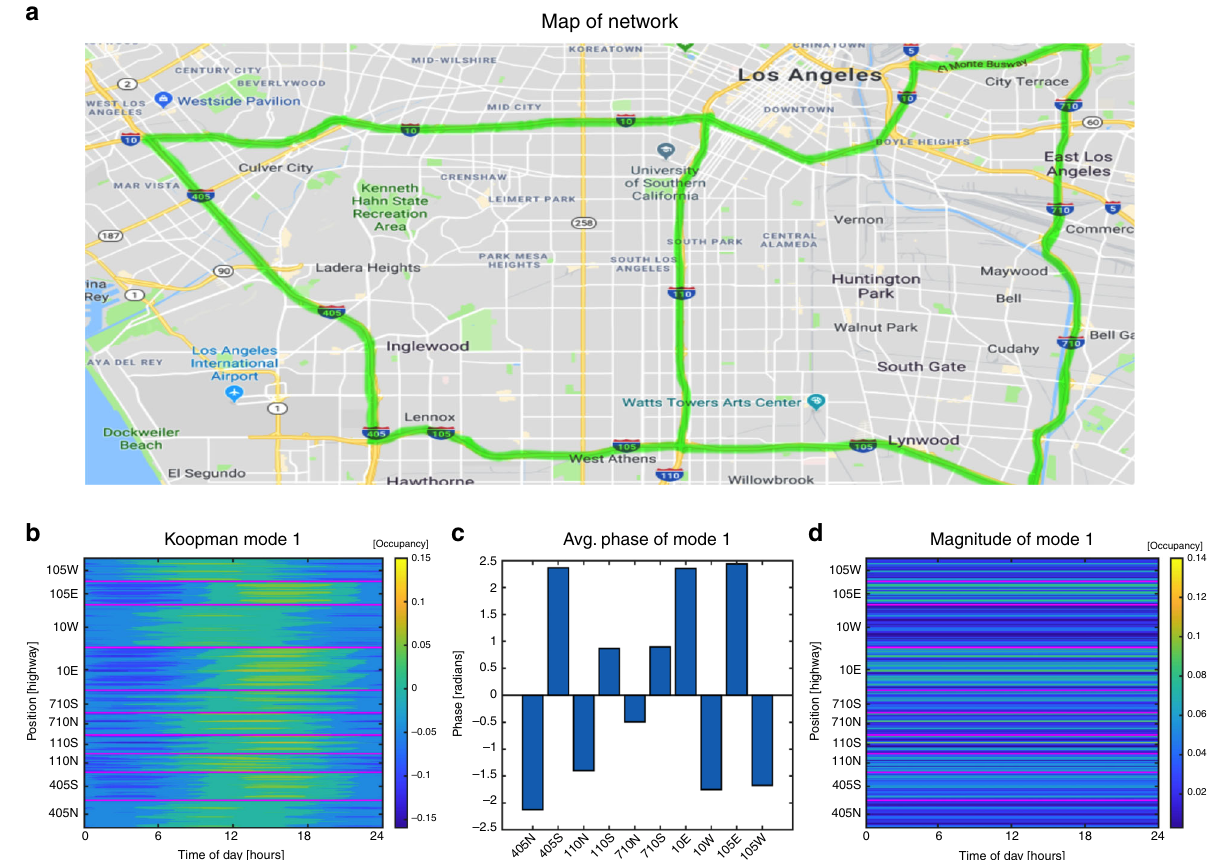
Fig. 9 Map of the Los Angeles multi-lane network and the resulting 24-hour Koopman. a Map of the multi-lane network obtained from Map © data 2019 Google. The highways studied are highlighted and data for three lanes of both north – south and east – west directions are collected for the entire day of December 20th, 2018. b The 24-hour Koopman mode revealing the order of congestion within the network. Speci fi cally, by observing the staggering of the amplitude one can see that during the morning rush the westbound I-105 and I-10 along with the northbound I-405 and I-110 jam fi rst. In the afternoon traf fi c switches directions and it is the eastbound and southbound directions of the previously mentioned highways which are jammed. This corresponds with the well-known fact the morning commuters generally travel from San Bernardino (east to west) and Orange County (southeast to northwest) into Los Angeles. c A plot of the average phase of the mode sorted by highway con fi rming the previously mentioned synchrony of congestion. Speci fi cally, the north and west directions seem to be in phase with each other and likewise for the south and east directions. d The magnitude of the 24-hour mode along with magenta-colored lines used to visually divide the differing highways. The magnitude of the mode reveals that the eastbound I-10 and I-105 highways are more occupied than the other